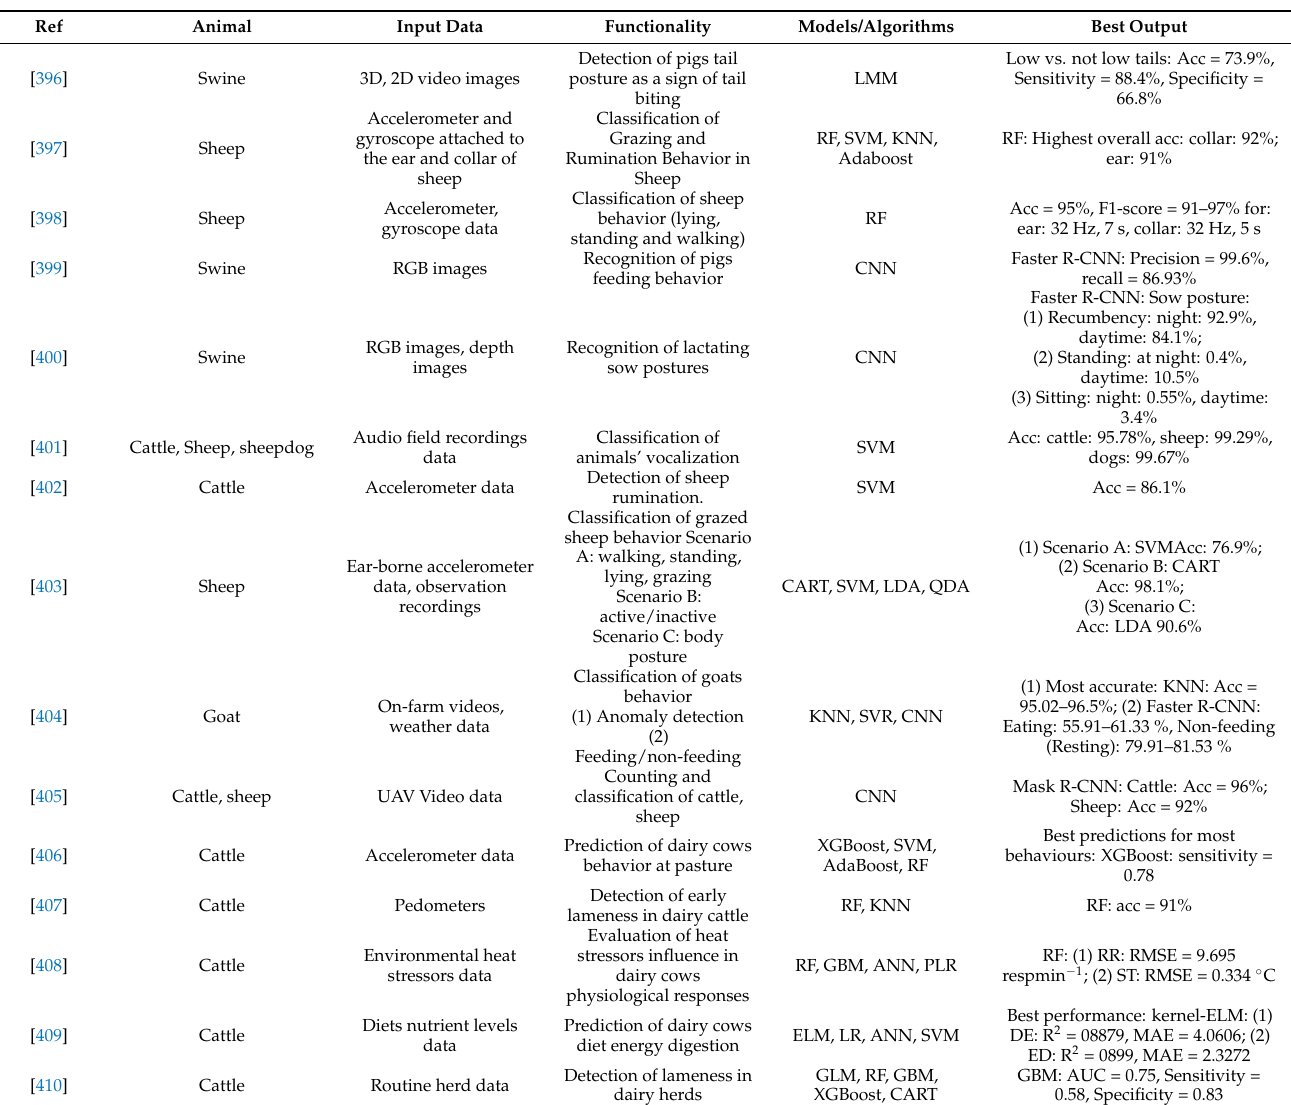
Table A8. Livestock Management: Animal